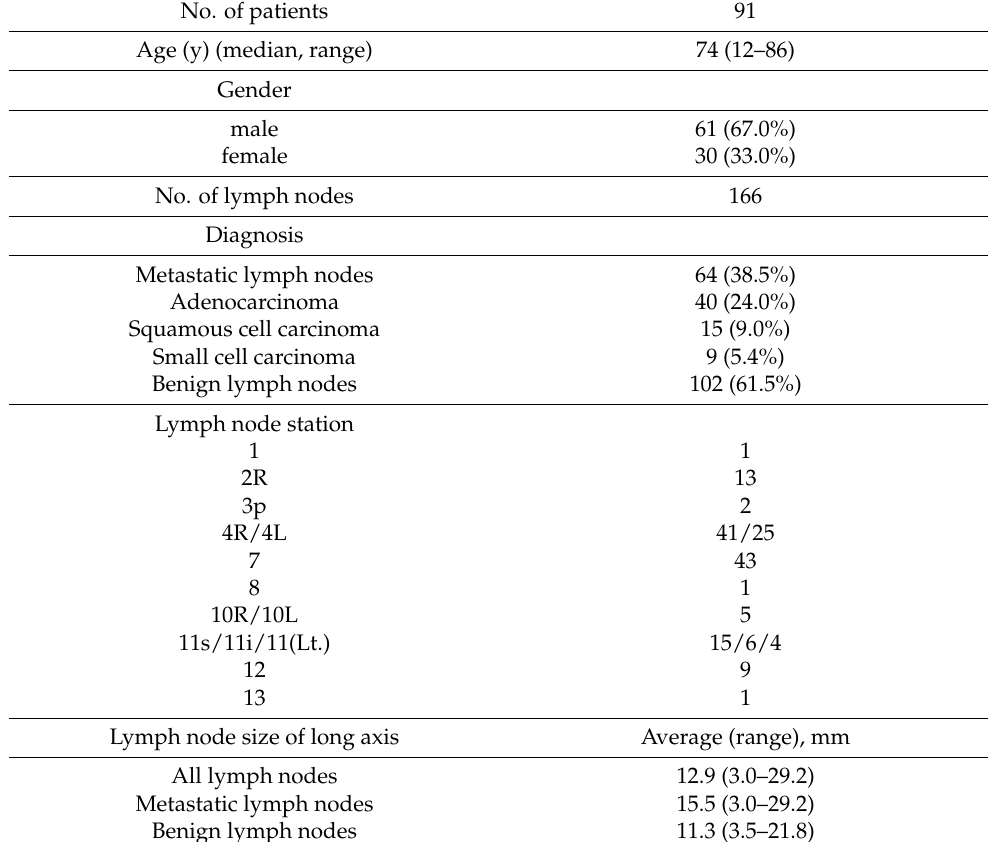
Table 1. Patients’ and nodal characteristics.